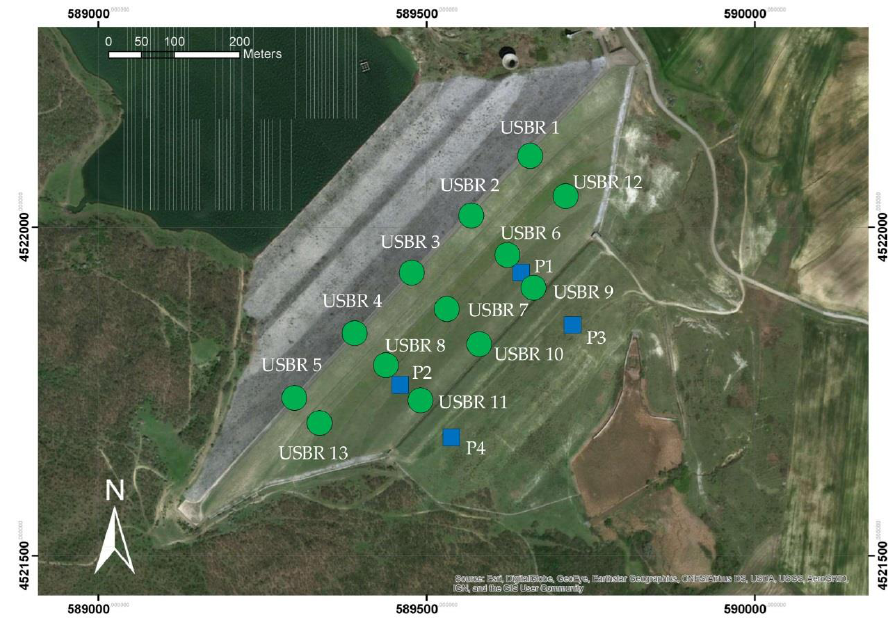
Figure 5. Position of the installed extensometers USBR model (green circles) and piezometers (blue squares) on the dam.